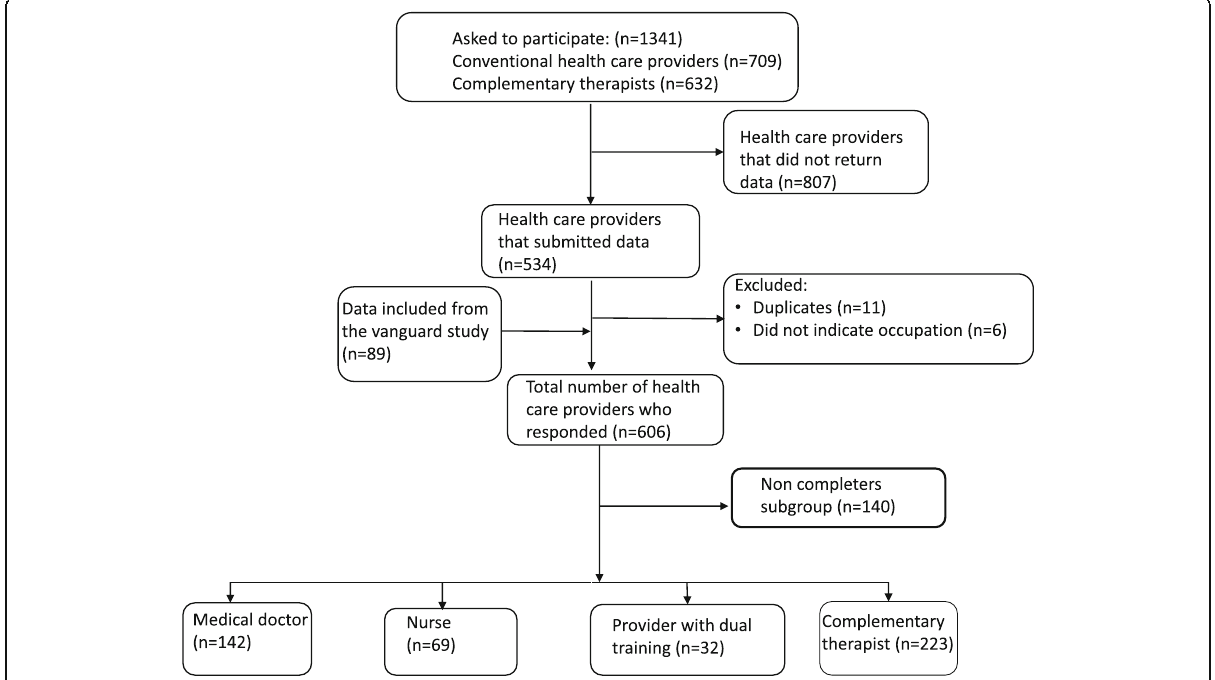
Fig. 1 Flow chart of the inclusion process in this